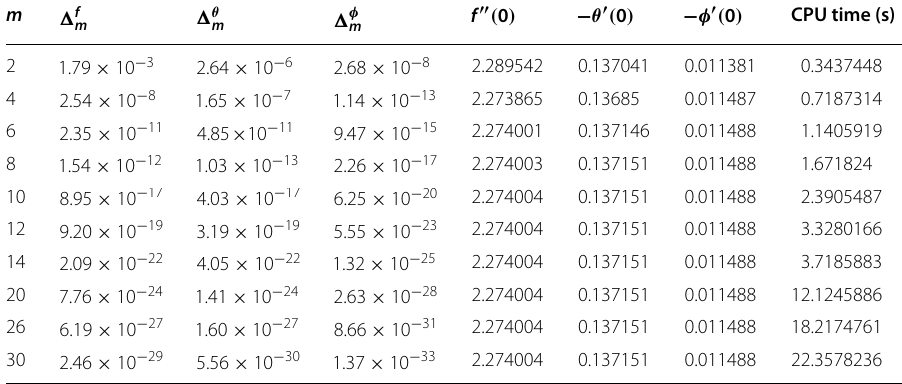
Table 3 Show Individual residual square error and OHAM solutions convergence at various